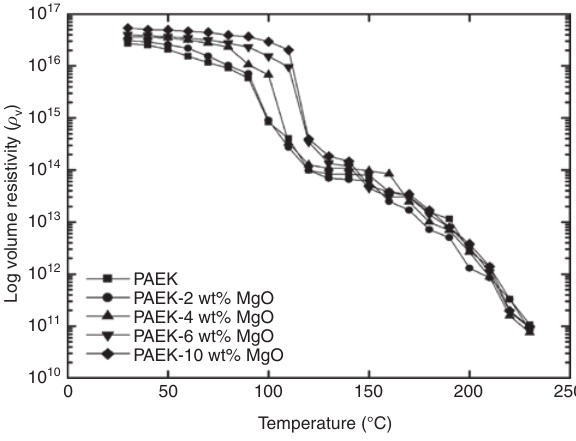
for PAEK-MgO nanocomposites. v